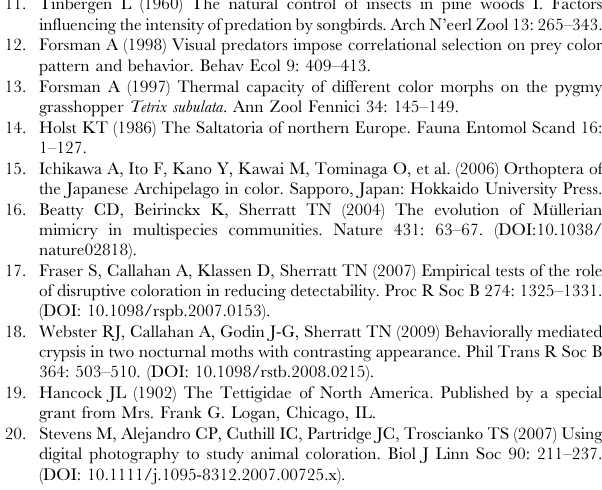
Figure S1 UV ad visible reflectance of T. japonica . Arrows show the body parts where reflectance spectra were